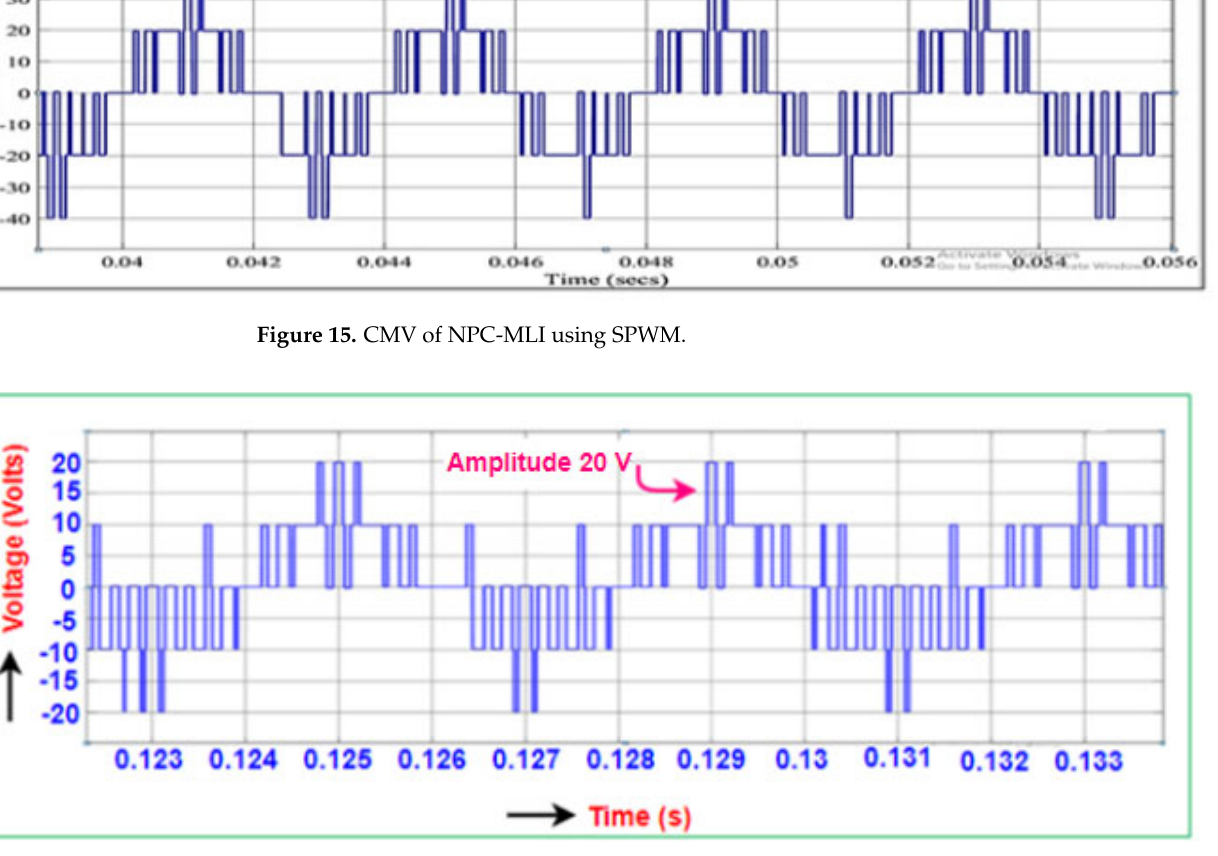
Figure 16. Common ‐ mode voltage of NPC multilevel inverter using MCSPWM.